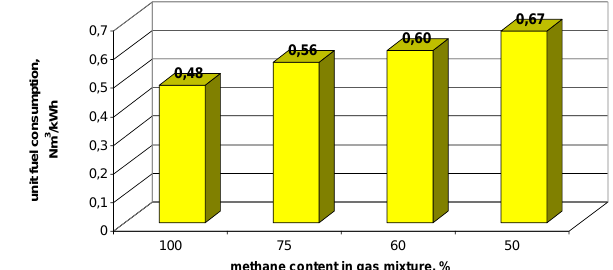
Fig. 12. Minimum unit fuel